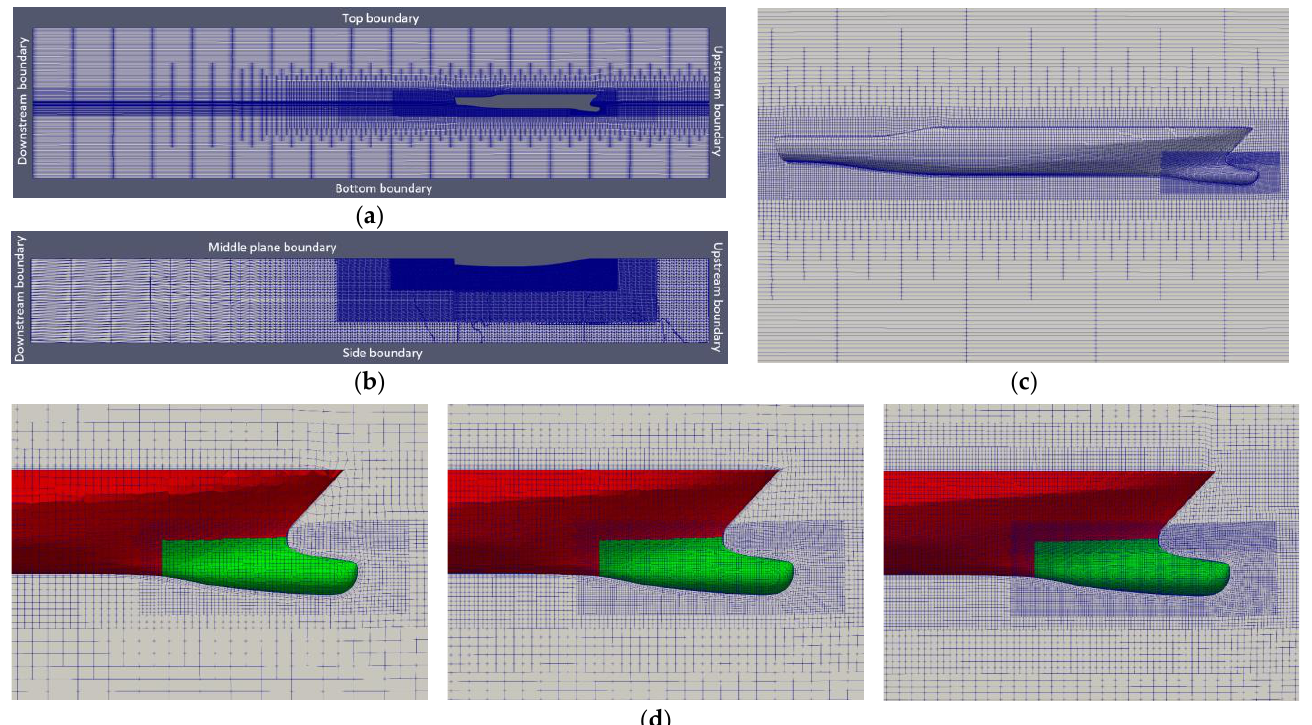
Figure 5. Grid generation for the ship with the optimal sonar dome (F0.225): ( a ) y = 0 plane (medium grid); ( b ) z = 0 plane (medium grid); ( c ) near ship’s hull (medium grid); ( d ) near ship’s bow and sonar dome (left to right: coarse, medium, fine grid explained in Section 3.3.1).